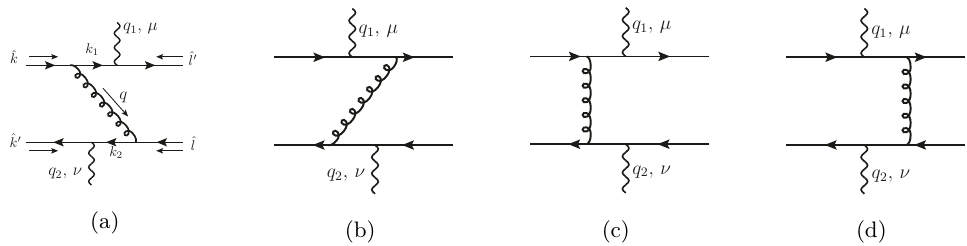
Figure 11. The Type- A diagrams, plus those with q 1 and q 2 switched. Relatively thicker gluon lines are used to indicate the large transverse momentum flow from one photon to another, in contrast to those in figure 12.